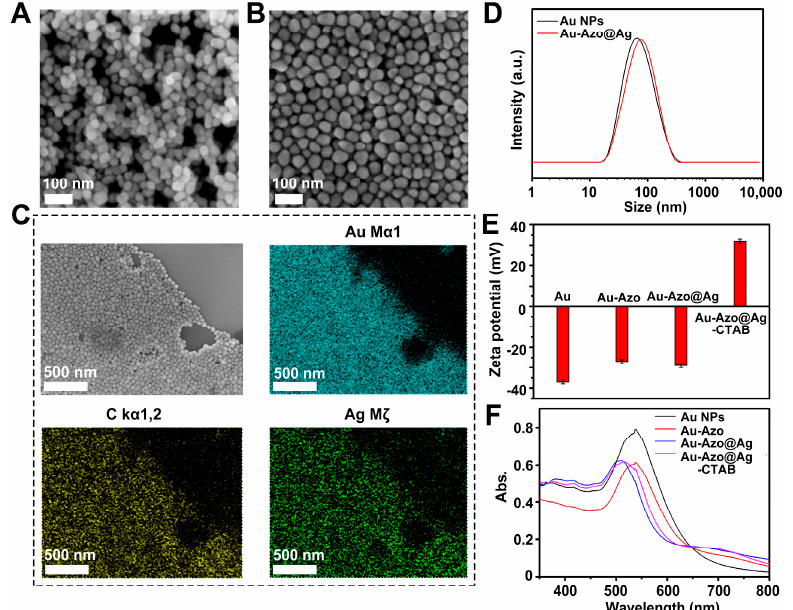
Figure 2. ( A ) SEM images of Au NPs. ( B ) SEM images of Au − Azo@Ag − CTAB NPs. ( C ) Energy dispersive spectroscopy (EDS) mapping images of Au − Azo@Ag − CTAB NPs (SEM). ( D ) Hydrated particle size of Au and Au − Azo@Ag NPs. ( E ) Zeta potential of different NPs. ( F ) UV-vis spectra of different NPs.